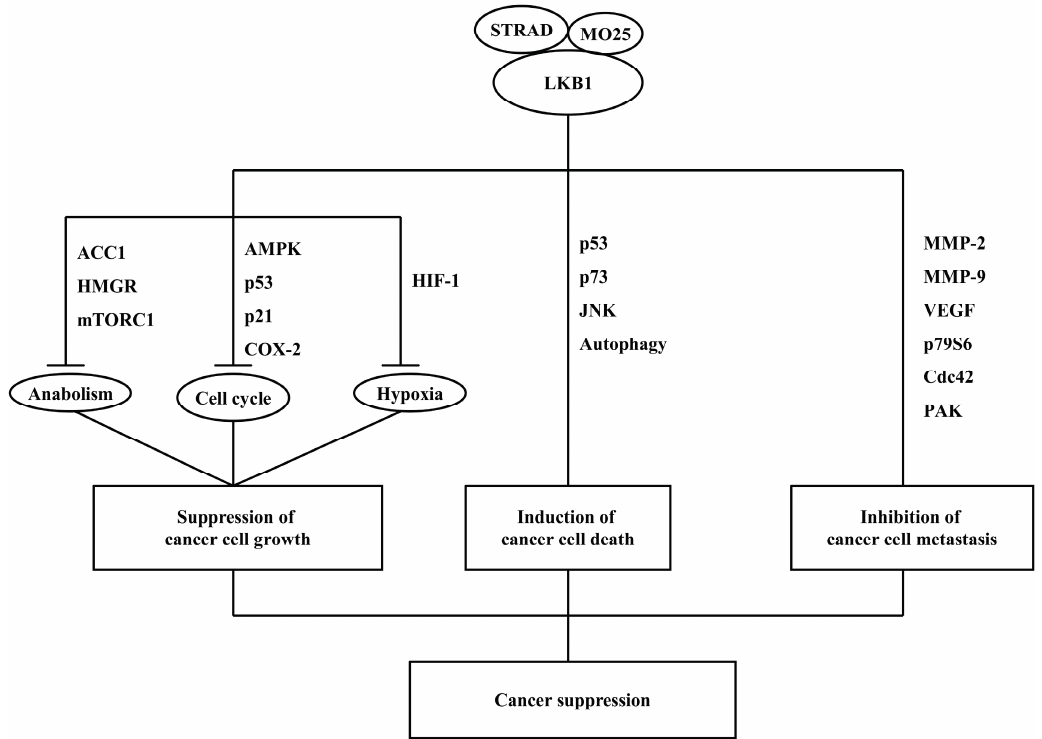
Figure 1. A diagram describing the potential mechanisms of liver kinase B1 (LKB1)-mediated cancer